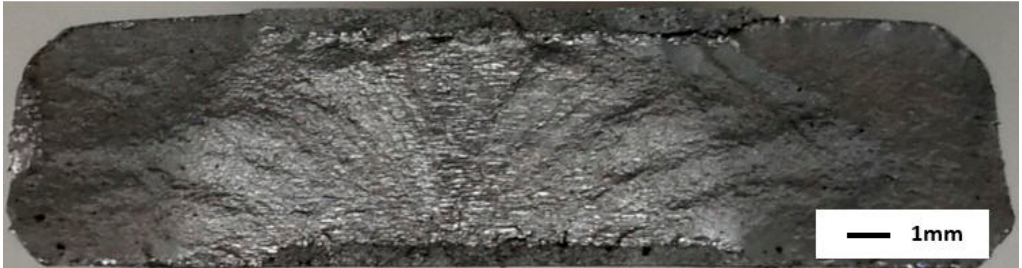
Figure 14. Failure surface associated with specimen 6061_F_2, failed at 87,958 cycles.